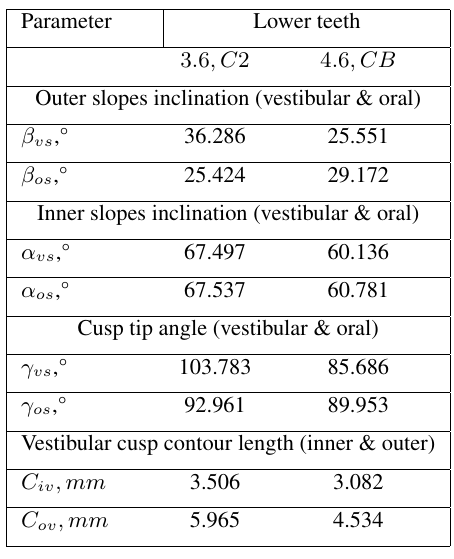
Table 2. Odontometric parameters for lower teeth